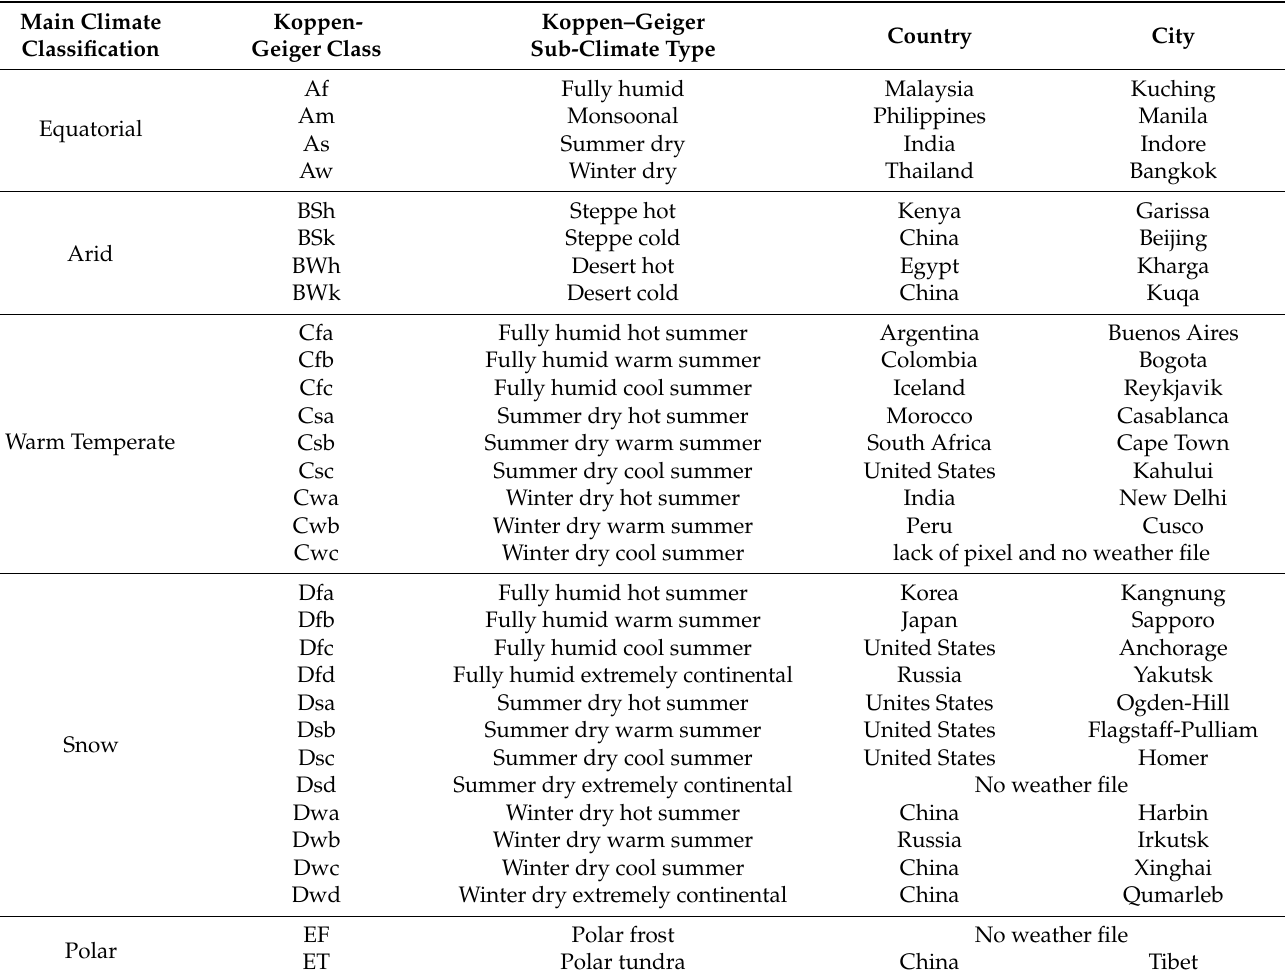
Table 1. Weather selection with Koppen–Geiger climate